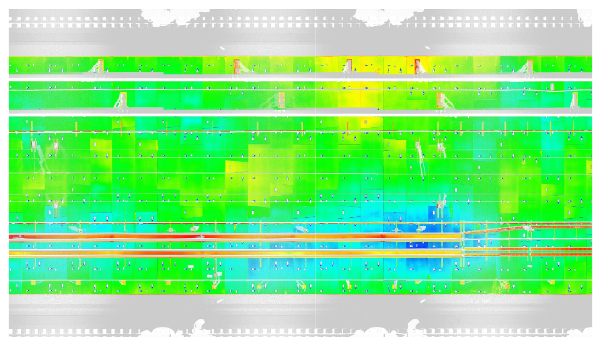
Figure 16. Distortions of Tunnel (cylindrical